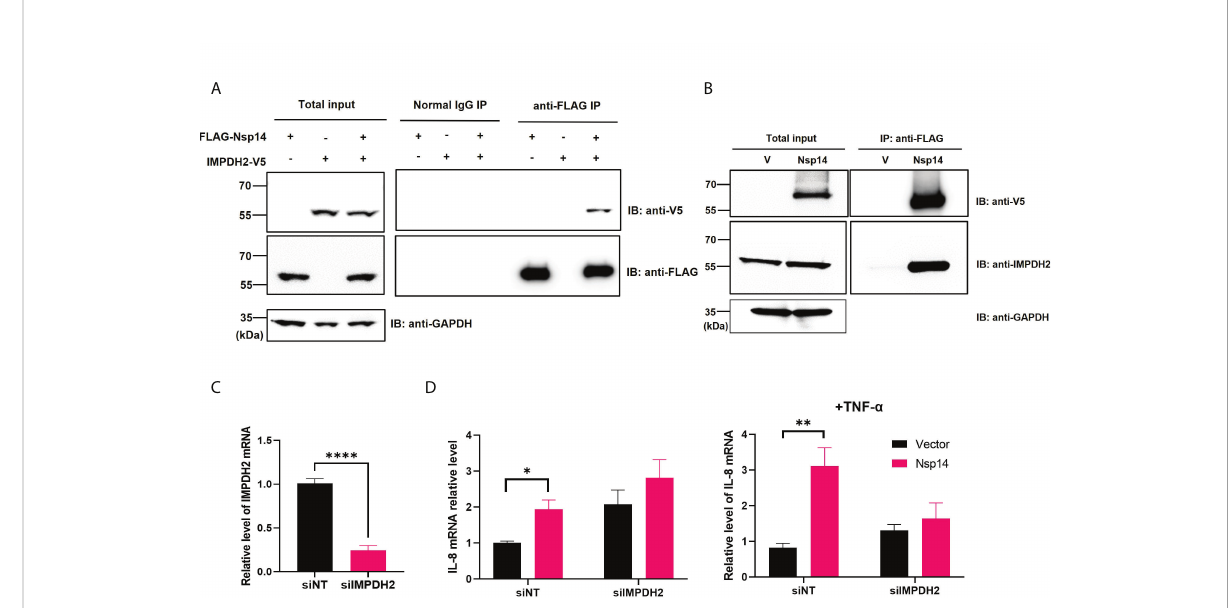
FIGURE 4 IMPDH2 associates with Nsp14 and is required for IL-8 upregulation by Nsp14. (A) HEK293T cells were transiently transfected with the vector expressing FLAG-Nsp14 or V5-IMPDH2, alone or together. Cell lysates were prepared and subjected to protein co-immunoprecipitation (co-IP) assays using anti-FLAG or control IgG antibody. Precipitated protein samples were analyzed by protein immunoblotting using anti-V5 and anti- FLAG antibodies. (B) HEK293T cells were transiently transfected with the empty vector (V) or FLAG-V5-Nsp14 vector. Cell lysates were prepared and subjected to protein co-IP assays using an anti-FLAG antibody. Precipitated protein samples were analyzed by protein immunoblotting using anti-V5 and anti-IMPDH2 antibodies. (C) HEK293T cells were transiently transfected with IMPDH2 or non-targeting (NT) siRNAs. The mRNA level of IMPDH2 was measured and normalized to siNT. (D) HEK293T cells transfected with IMPDH2 or NT siRNAs were further transfected with V5-FLAG-Nsp14 or empty vector. These cells were untreated or treated with TNF- a . Total RNAs were extracted. IL-8 mRNA was analyzed and normalized to the siNT and empty vector-transfected group. Results were calculated from 3 independent experiments and presented as mean +/- standard error of the mean (SEM). (*p<0.05; ** p<0.01; **** p<0.0001; by unpaired Student ’ s t-test).